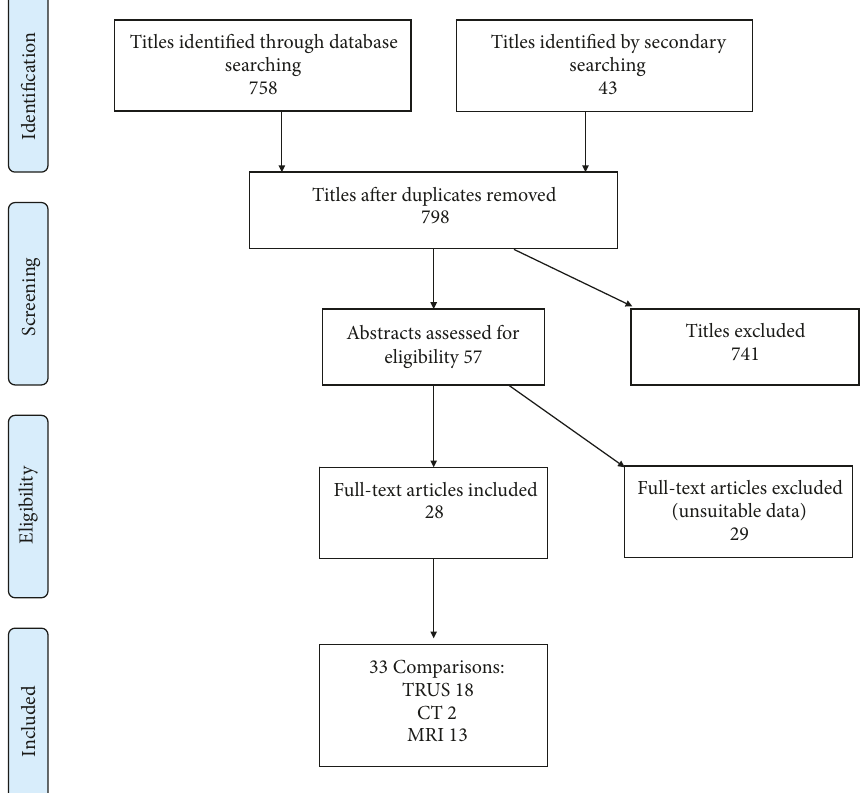
Figure 1: Results of the search